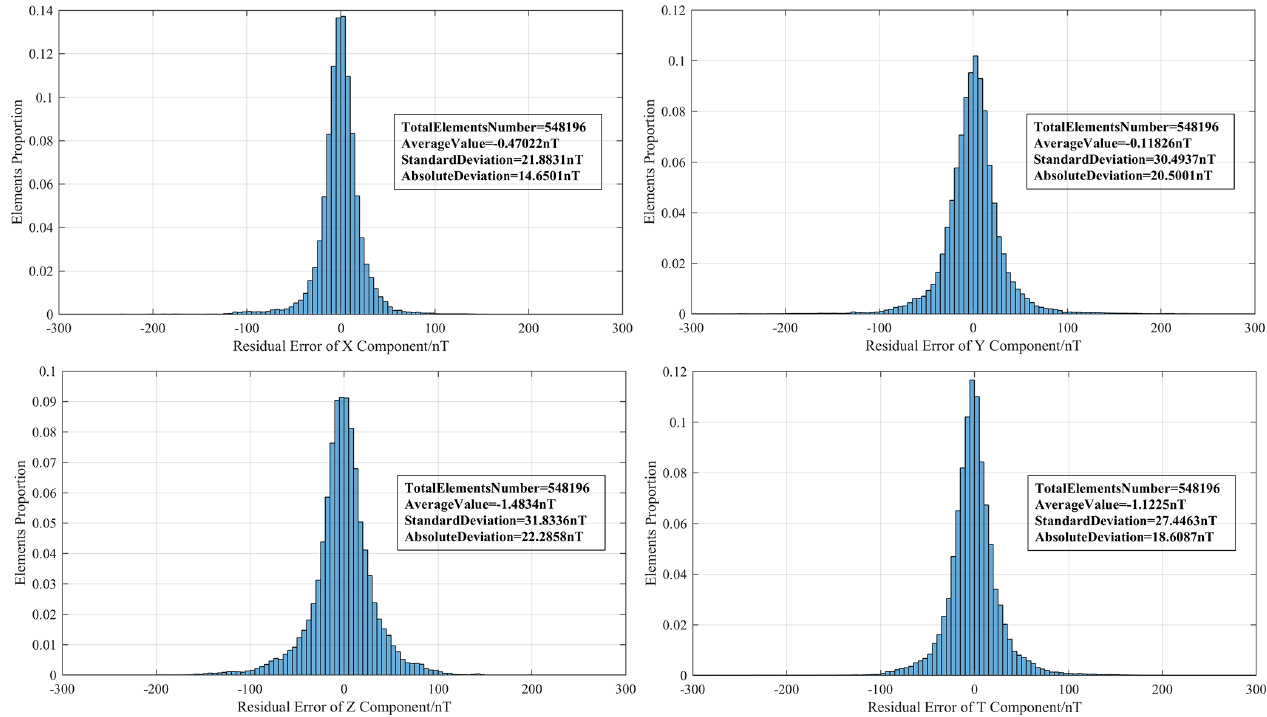
Figure 17. A statistical distribution of the LOPS Magnetic field vector and intensity residual for 1 to 30 April 2018 (after removing the core, crustal, and magnetospheric fields as given by the CHAOS-7 model; Finlay et al.,